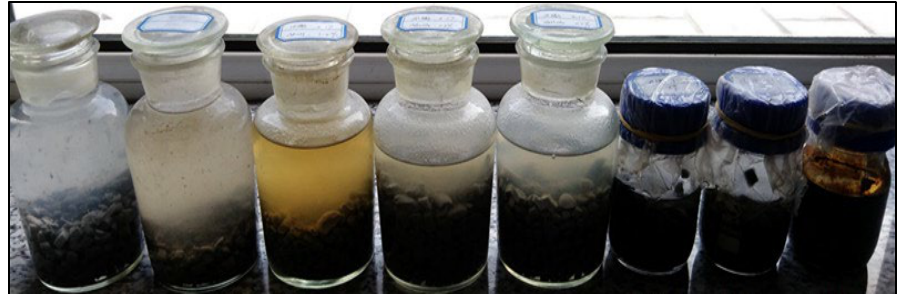
Figure 4. Different media for soaking water-swellable rubber. From left to right, they are clean water, sewage, sodium hydroxide, sodium carbonate, sodium bicarbonate, oil production, crude oil, kerosene.